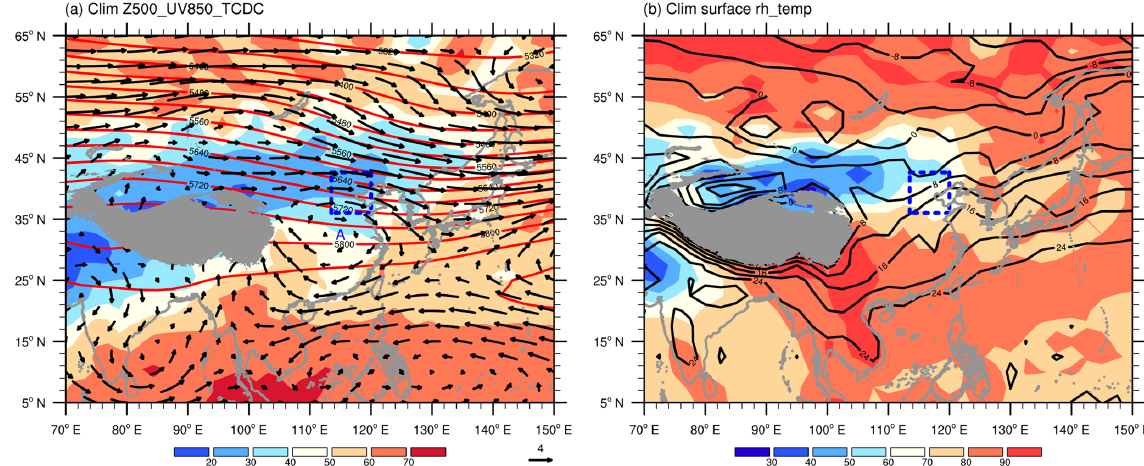
Figure 3. The climatological-mean (1960–2017) autumnal (a) Z500 (contours; gpm), UV850 (vectors; ms − 1 ) and total cloud (shaded; %) and (b) surface relative humidity (shaded; %) and surface air temperature (contours; ◦ C). The gray shaded area denotes the Tibetan Plateau, and the blue dashed box delineates the research domain of the BTH region. The letter A represents the center of anticyclonic circulation.